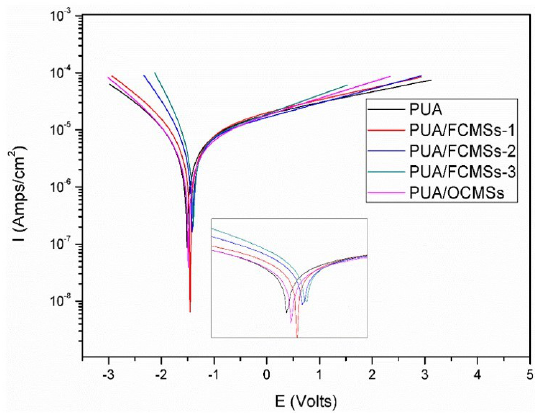
Figure 16. The polarization curve of UV-curable polyurethane composite coatings. Table 2. Electrochemical characteristic parameters of UV-curable polyurethane composite coatings.